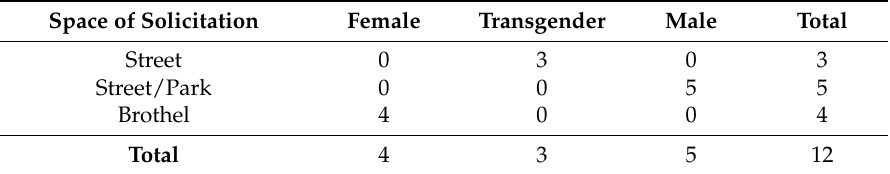
Table 4. Sex worker participant spaces of solicitation in Guayaquil, Ecuador by gender. Space of Solicitation Female Transgender Male Total Street 2 1 0 3 Brothel 3 0 0 3 Social media 0 0 1 1 Total 5 1 1 7 Table 5. Sex worker participant spaces of solicitation in Machala, Ecuador by gender. Space of Solicitation Female Transgender Male Total Street 0 3 0 3 Street/Park 0 0 5 5 Brothel 4 0 0 4 Total 4 3 5